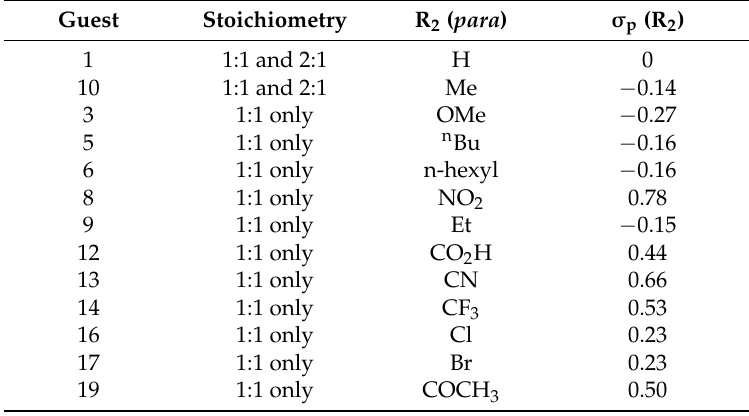
Table 4. Comparison of para -substituted 2-[(R-Phenyl)amine]-1,4-naphthalenediones which show 2:1 and 1:1 vs. only 1:1 complexes with β